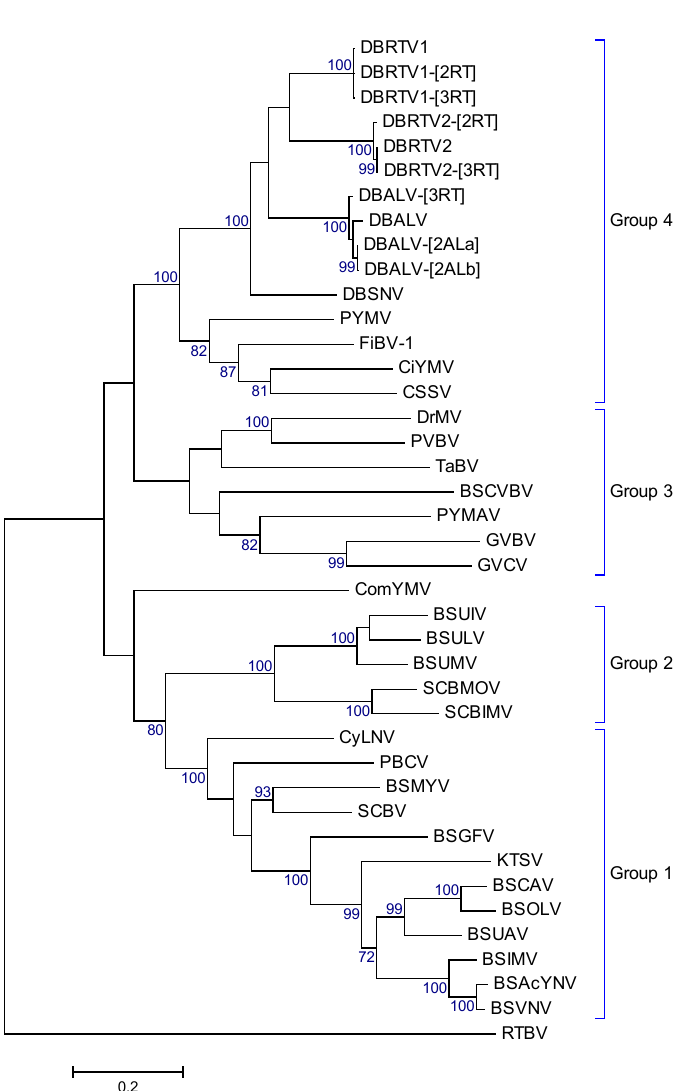
Figure 6. Maximum Likelihood phylogenetic tree obtained from the alignment of the deduced amino acid sequences of the ORF3 products of DBALV-[2ALa], DBALV-[2ALb], DBRTV1, DBRTV1-[2RT], DBRTV1-[2RT], DBRTV2, DBRTV2-[2RT], DBRTV2-[3RT], DBALV-[3RT], DBALV, DBSNV, other